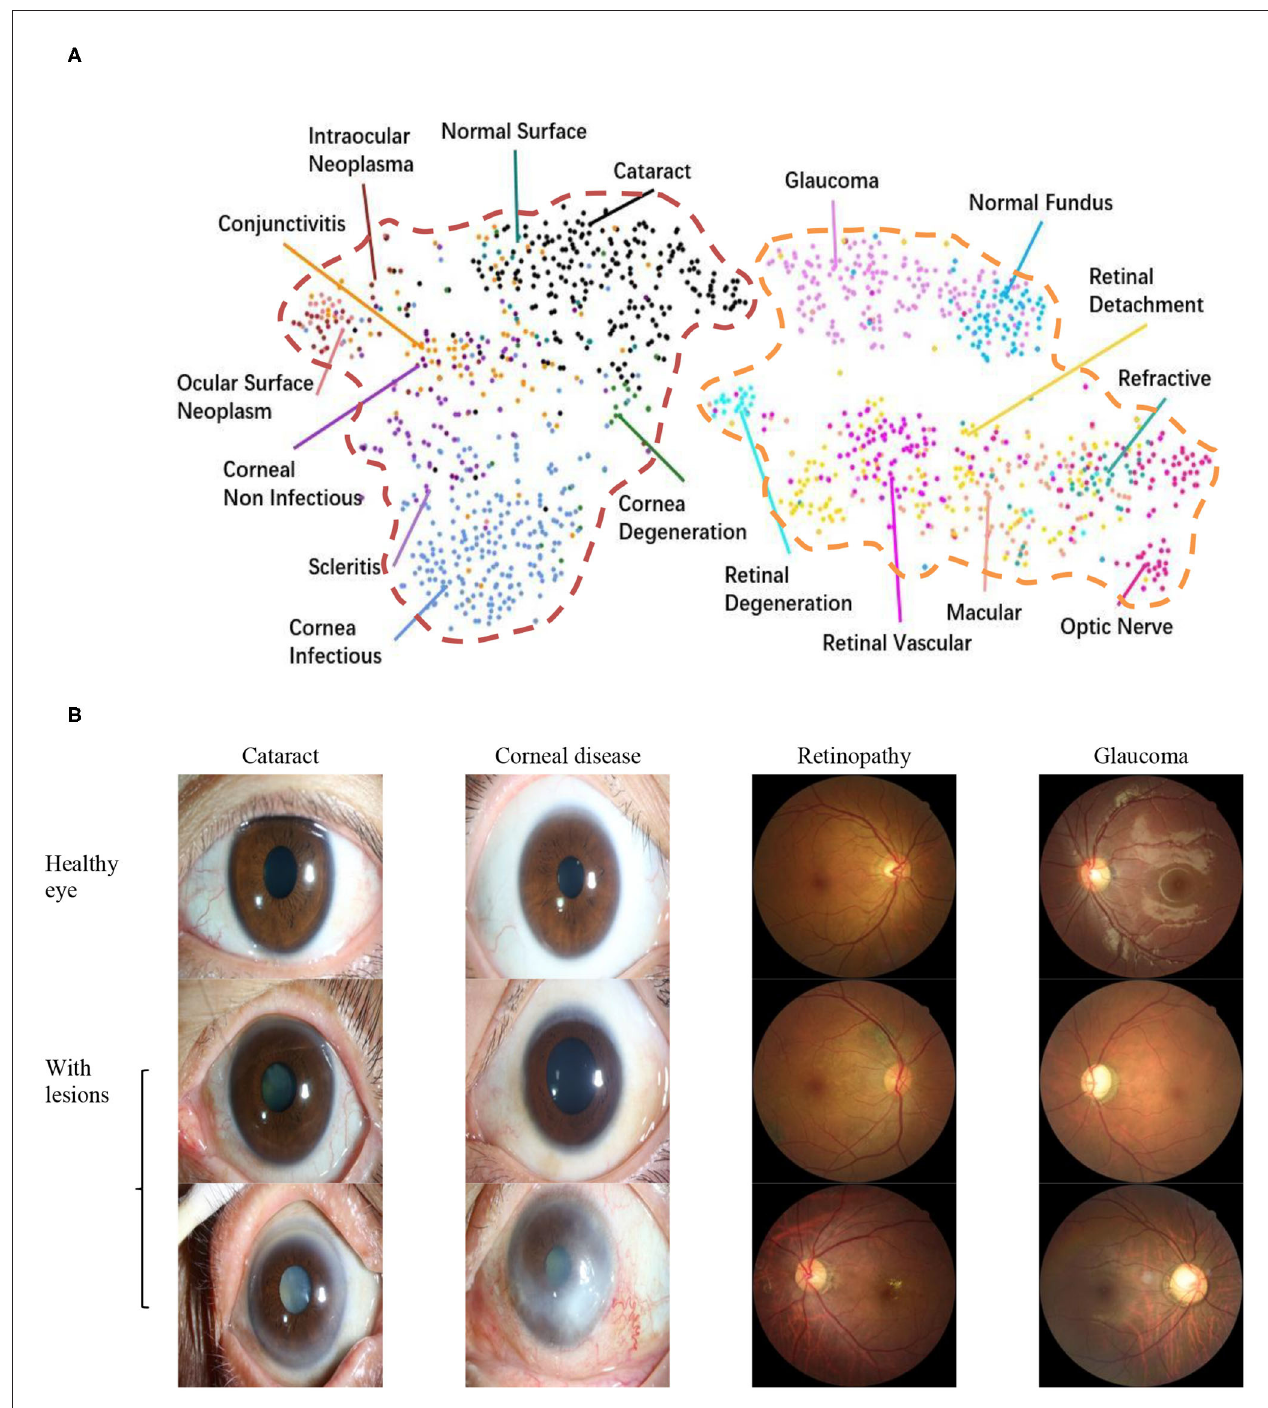
FIGURE 1 | Dataset. (A) t-Distributed stochastic neighbor embedding visualization of the collected dataset consisting of 17 major ocular disease classes (100 subtypes), leading to visual impairment, clustered according to deep features generated from the last layer of trained networks. Colored point clouds represent images with different visual impairment diseases. This visualization represents the ability of our method to objectively separate normal patients from early cases of visual impairment diseases for referral. (B) Example ocular surface and retinal images for the eye with some common diseases or healthy eye. In this study, the first two levels of the taxonomy consisting of 17 major ocular disease classes (100 subtypes) were used in performance evaluation.